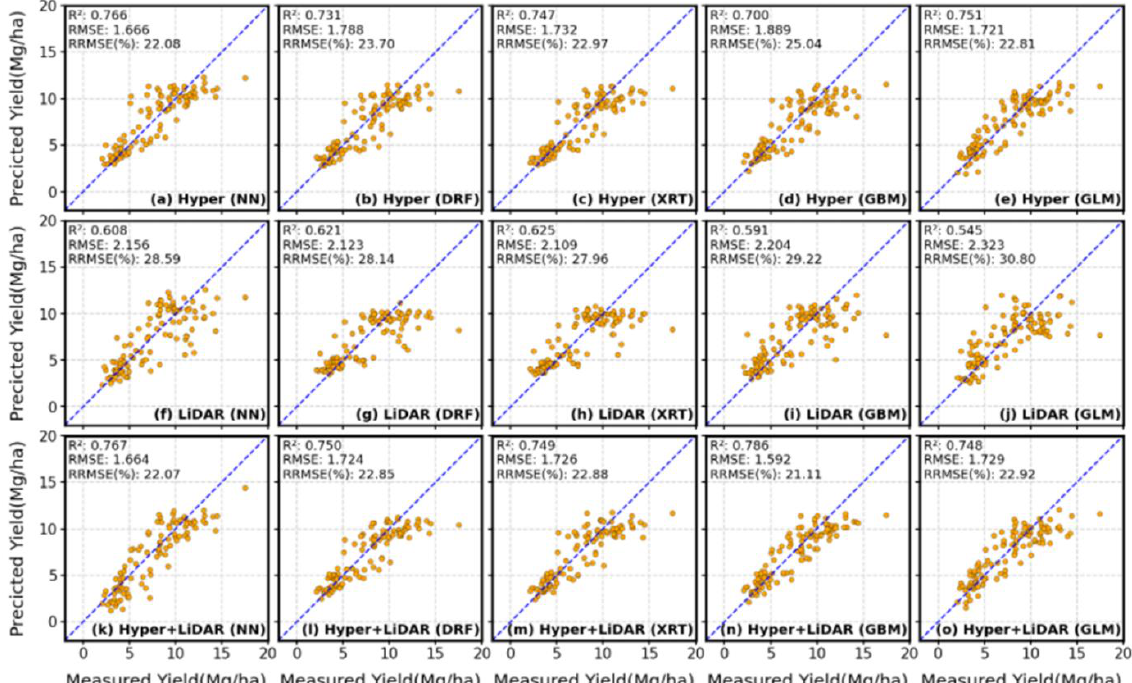
Figure 4. Scatter Plots of Measured VS Predicted Maize Yield Using Different Models with Hyper-based, LiDAR-based, and Hyper + LiDAR-based